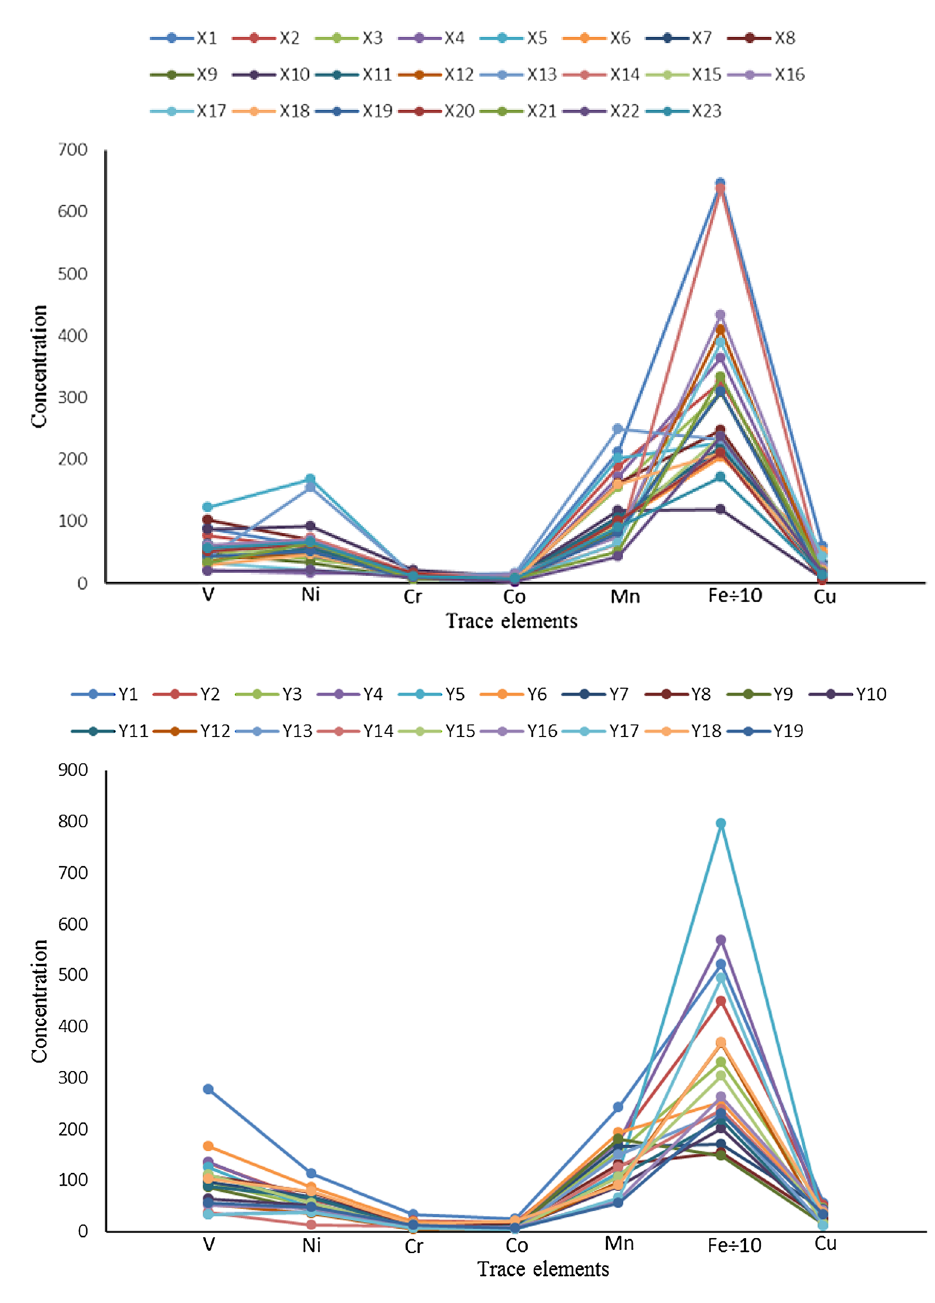
Fig. 4 Trace elements distribu- tion patterns of kerogens from Well X